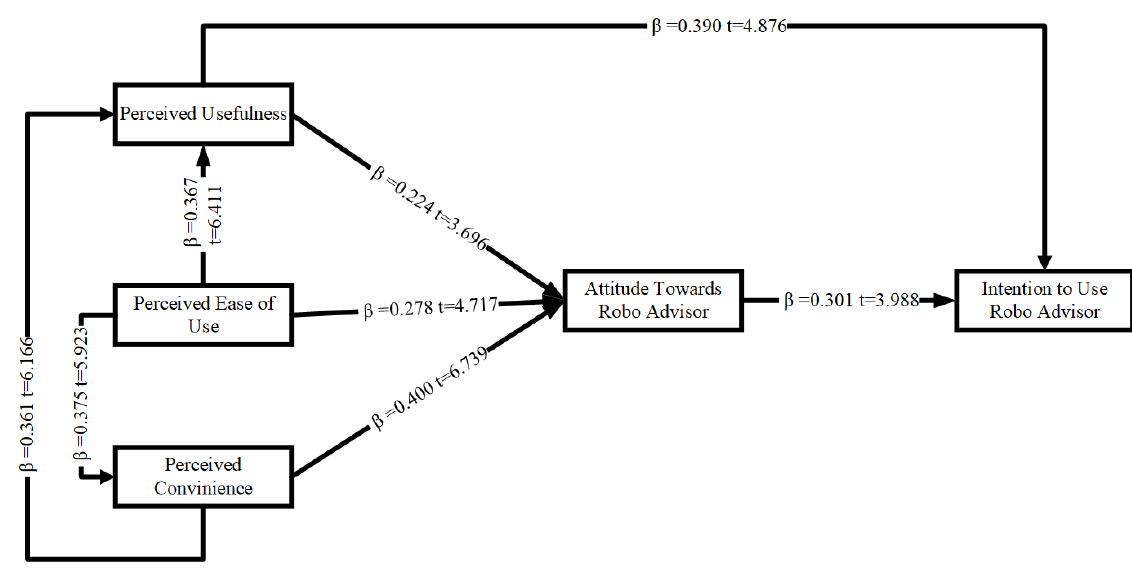
Figure A2. Base Line Structural Model.